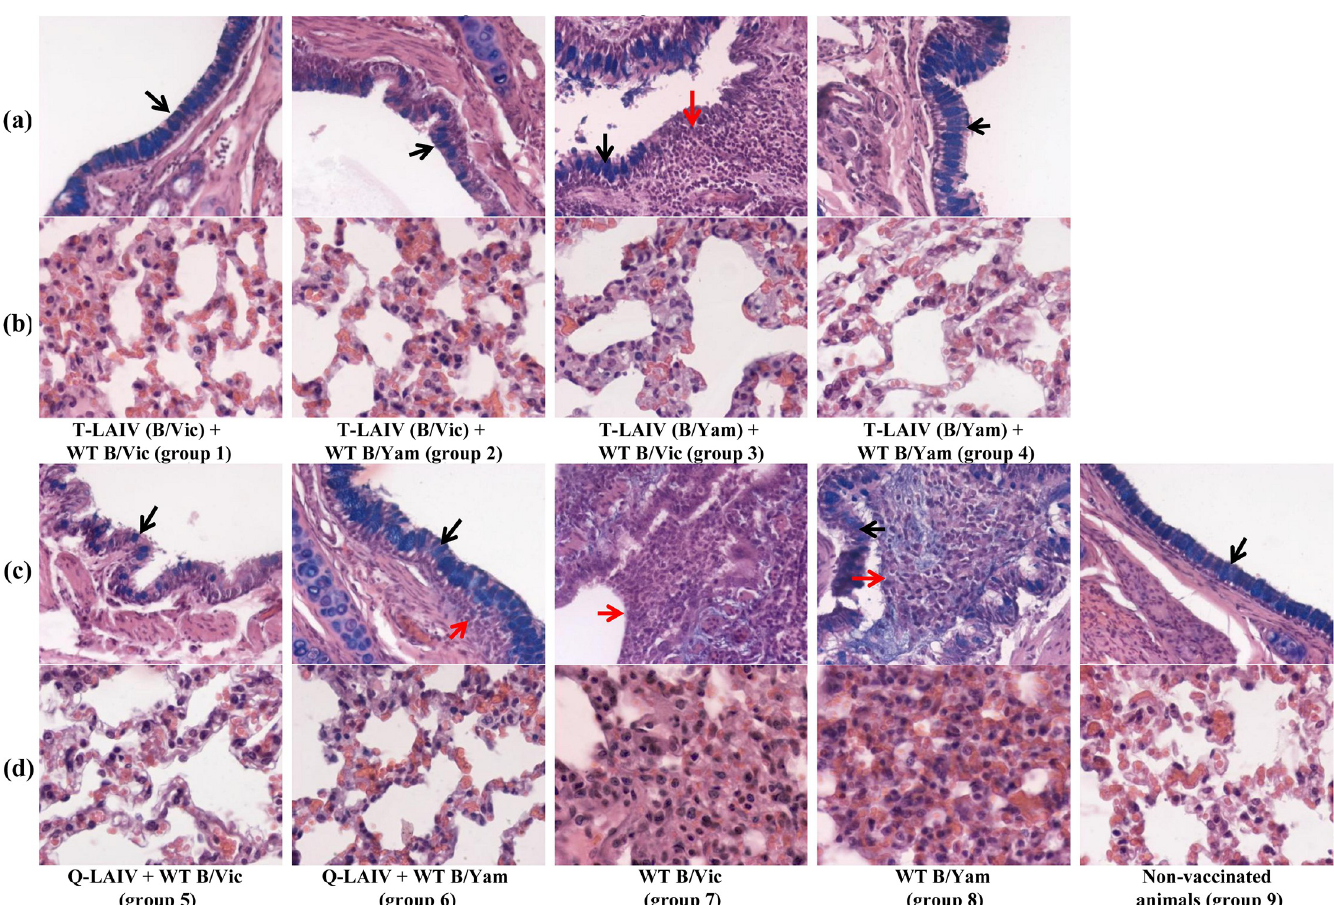
Fig 4. Histological view of the lungs. Red arrows indicate inflammation; black arrows indicate presence of goblet cells. (a) Bronchus. Alcian blue, H&E x 200; (b). Alveolar tissue. Alcian blue, H&E x 400; (c) Bronchus. Alcian blue, H&E x 200; (d). Alveolar tissue. Alcian blue, H&E x 400.